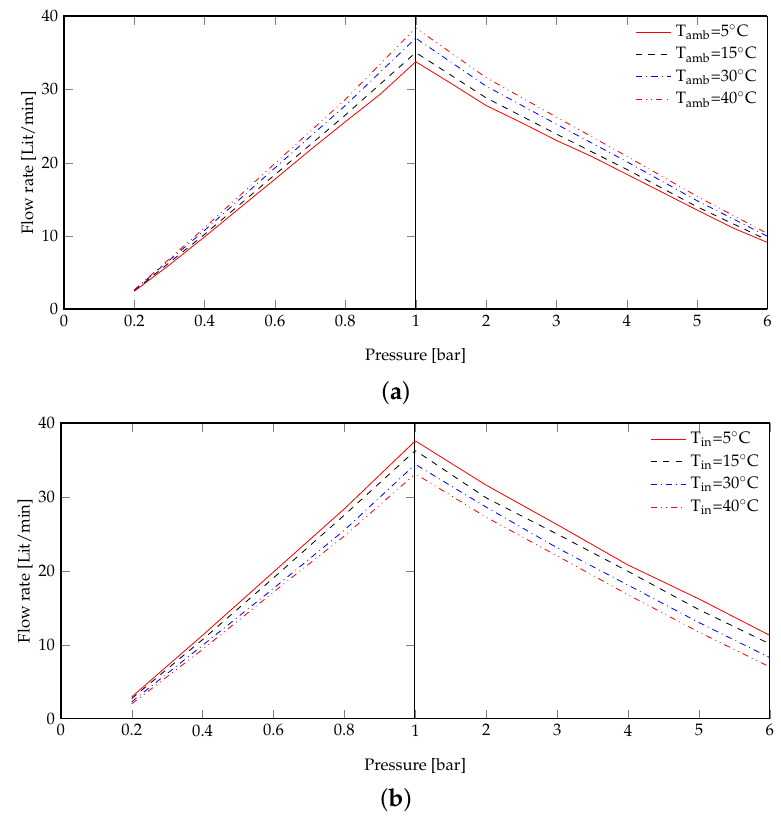
Figure 9. The effect of ( a ) ambient temperature and, ( b ) gas inlet temperature on the diaphragm compressor flow rate for pressure range between 1 to 6 bar (gauge). As it is stated, an increase in pressure leads to a flow rate decrease. It is possible, 298 however, the flow rate changes due to ambient or inlet temperatures. Figure 9 (a) shows 299 that the lower ambient temperature ( T amb ) lead to a lower flow rate; dropping the ambient 300 temperature from 40 to 5 ◦ C can lead to a 7 lit/min drop in the flow rate once the pressure 301 is 1 bar. However, the effect of ambient temperature on the flow rate tends to reduce at 302